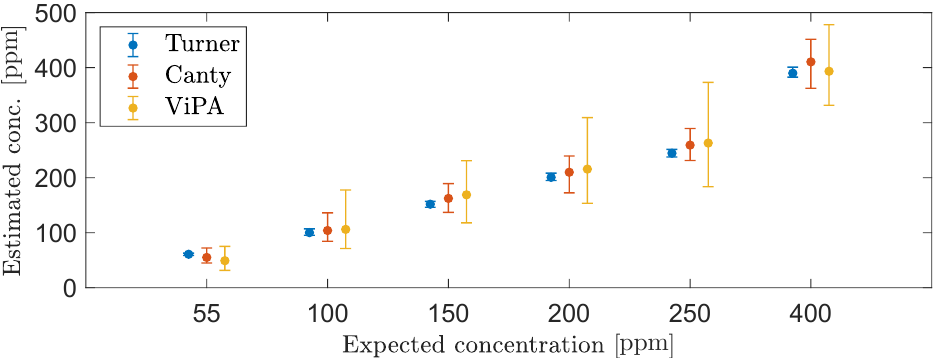
Figure 13. Error bars representing the mean, minimum, and maximum OiW concentrations based on the average concentration obtained each minute from C 2 and C 3 , together with error bars based on measurement every 10 s from C 1